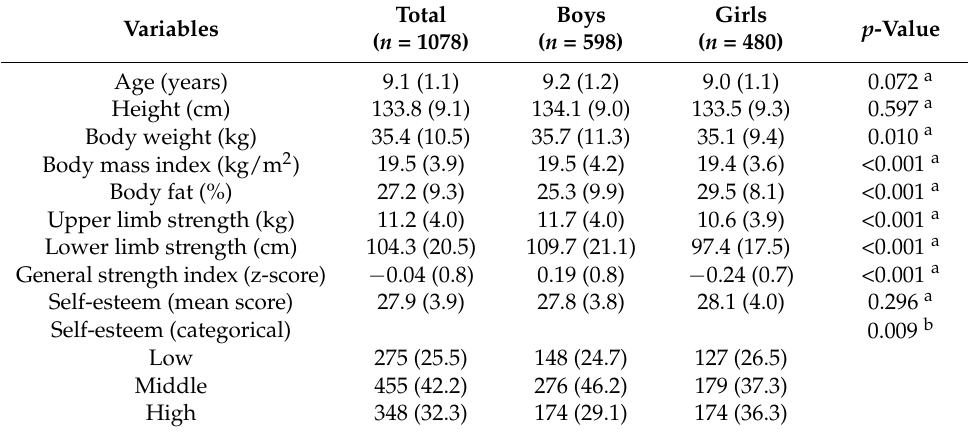
Table 1. Descriptive analysis (mean (SD) or n (%)) of the sample. Variables